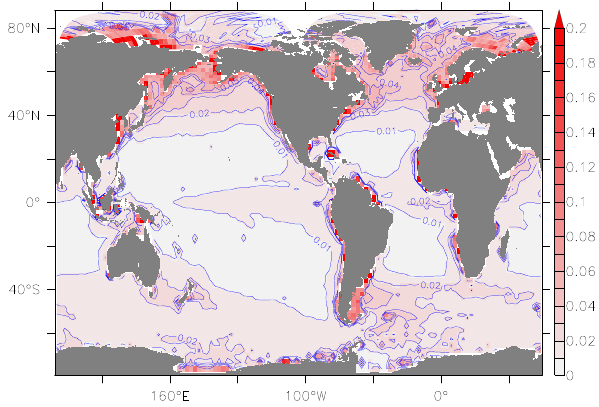
Figure 7. The spatial distribution of a dg ( 443 ) as prescribed in the model runs for this paper, mapped onto the CM2Mc ESM tracer grid with data extrapolated into polar regions.